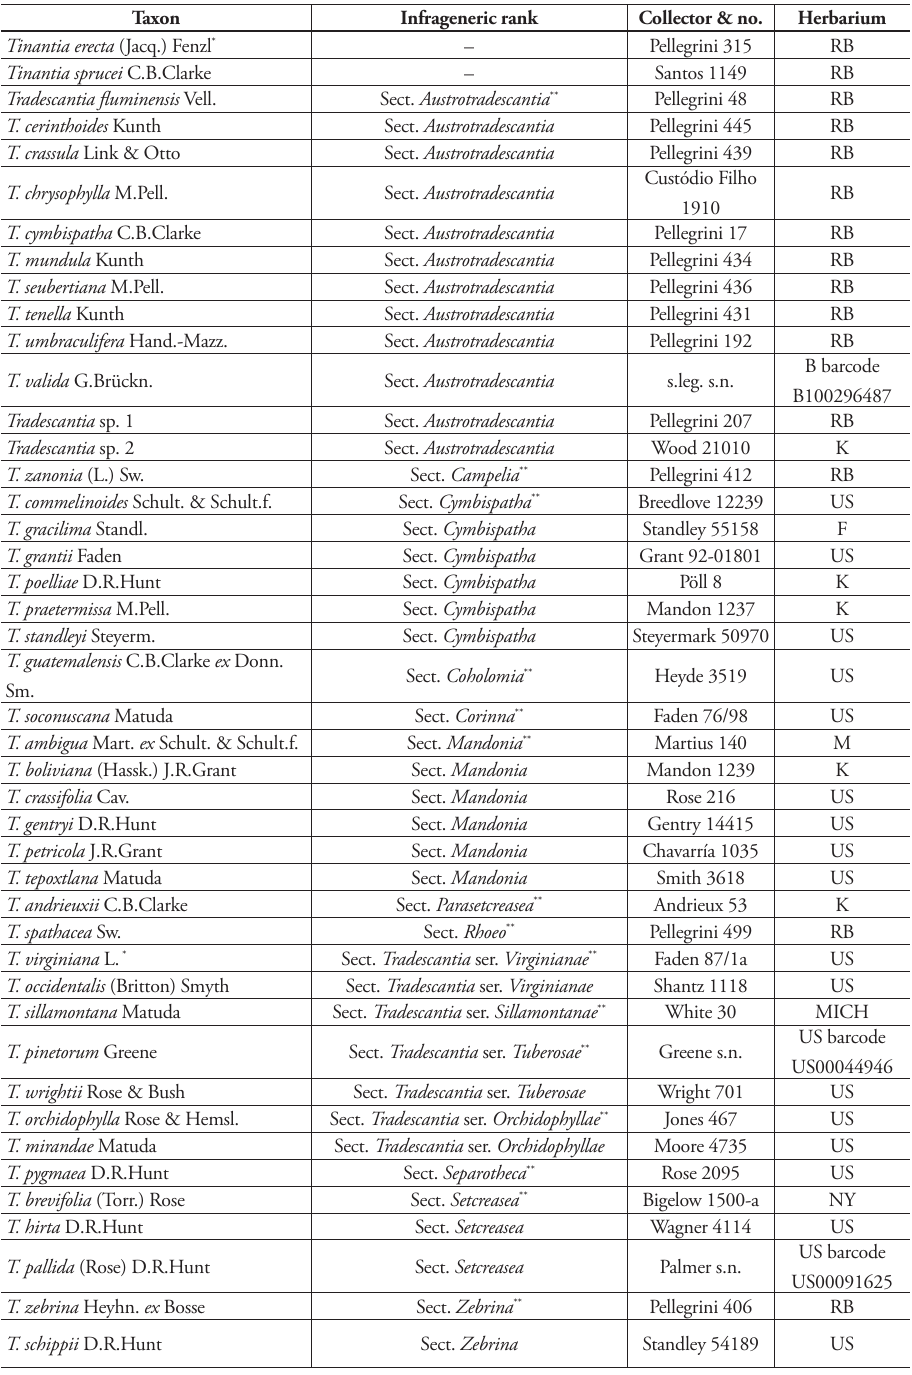
Table 1. Voucher specimens used in the phylogenetic analysis. * Type species of the genus. ** Type species of the infrageneric rank.